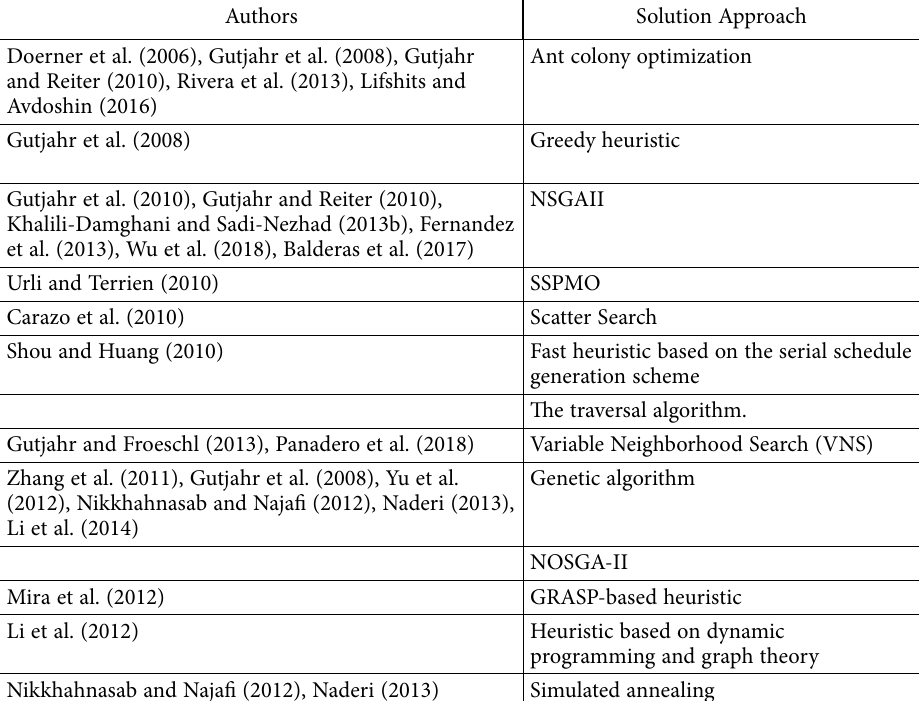
Table 15. Heuristic and meta-heuristic approaches Authors Solution